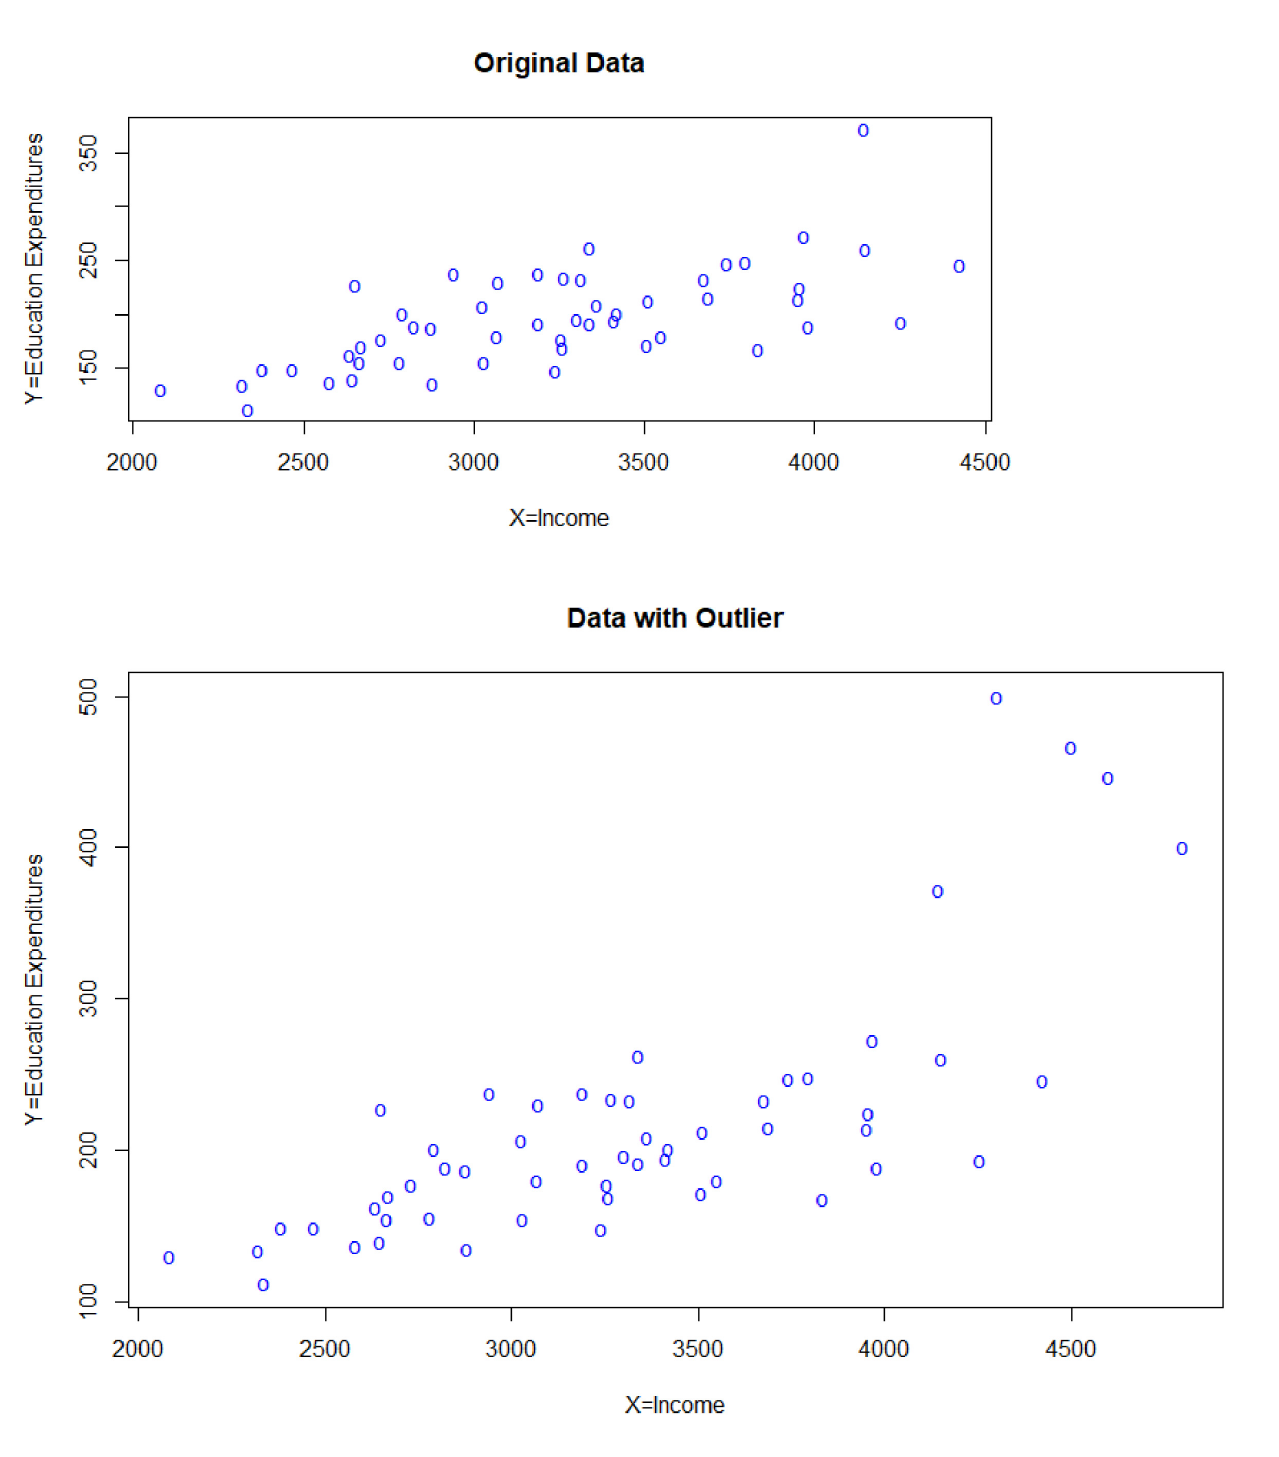
Fig 3. Scatter plot of public school expenditures dataset.